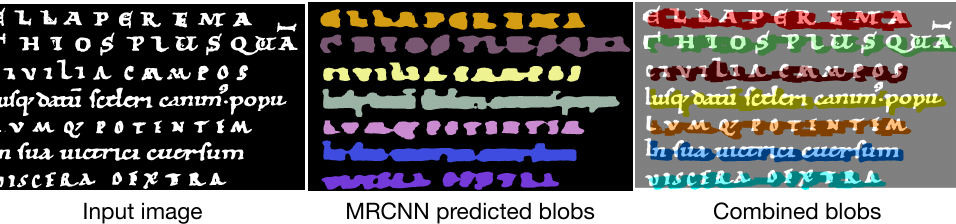
Figure 11. Disconnected MRCNN blobs are connected to enable applying Diva evaluator. As can be seen in the middle image, the Mask MRCNN segmented each line correctly, however, each line contain several disconnected segmented. On the right is the resulting polygon from combining the MRCNN blob prediction.